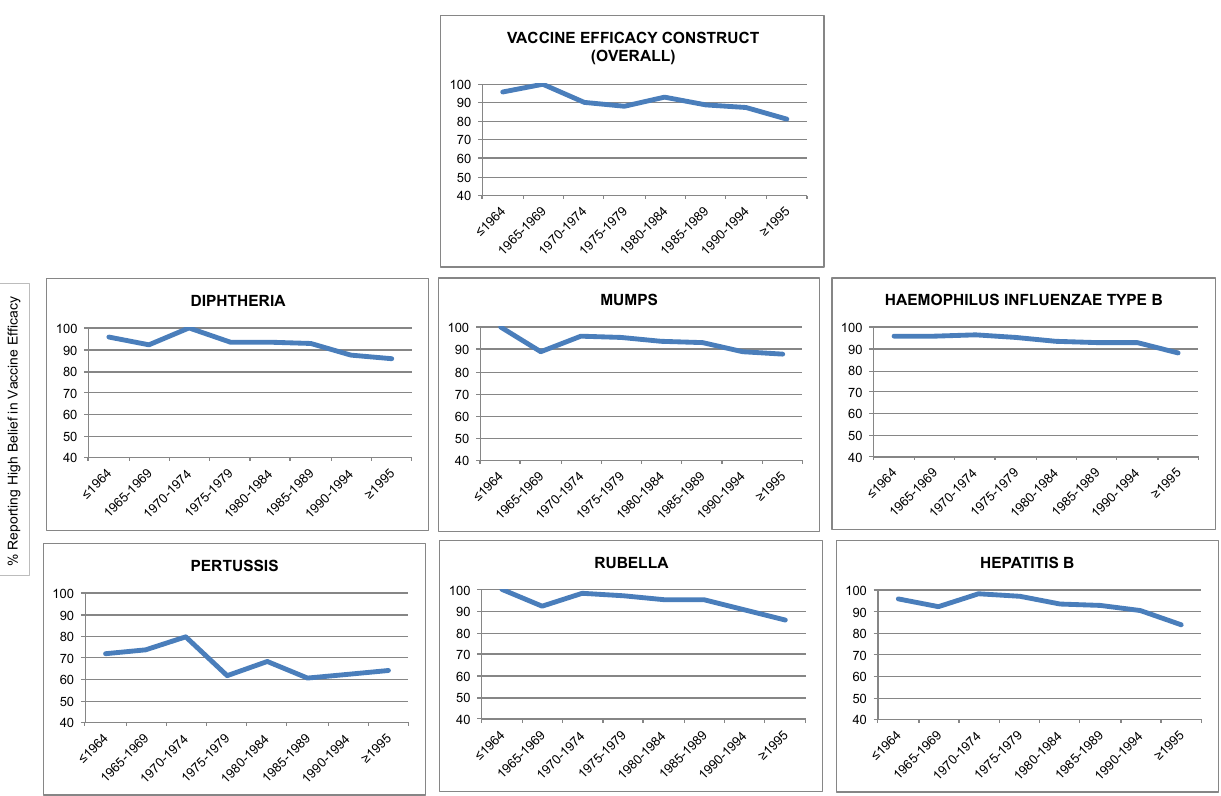
Figure 1. Percentage of providers reporting high belief in vaccine efficacy by year of health professional